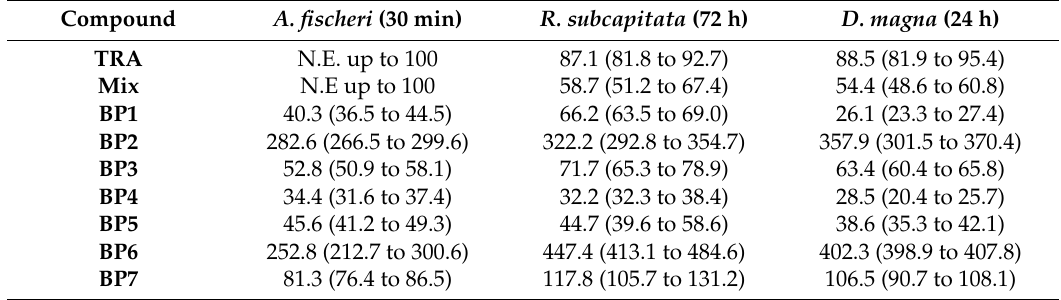
Table 1. Ecotoxicity of TRA, chlorinated mixture and by-products (all values in mg/L ± 95% IC).